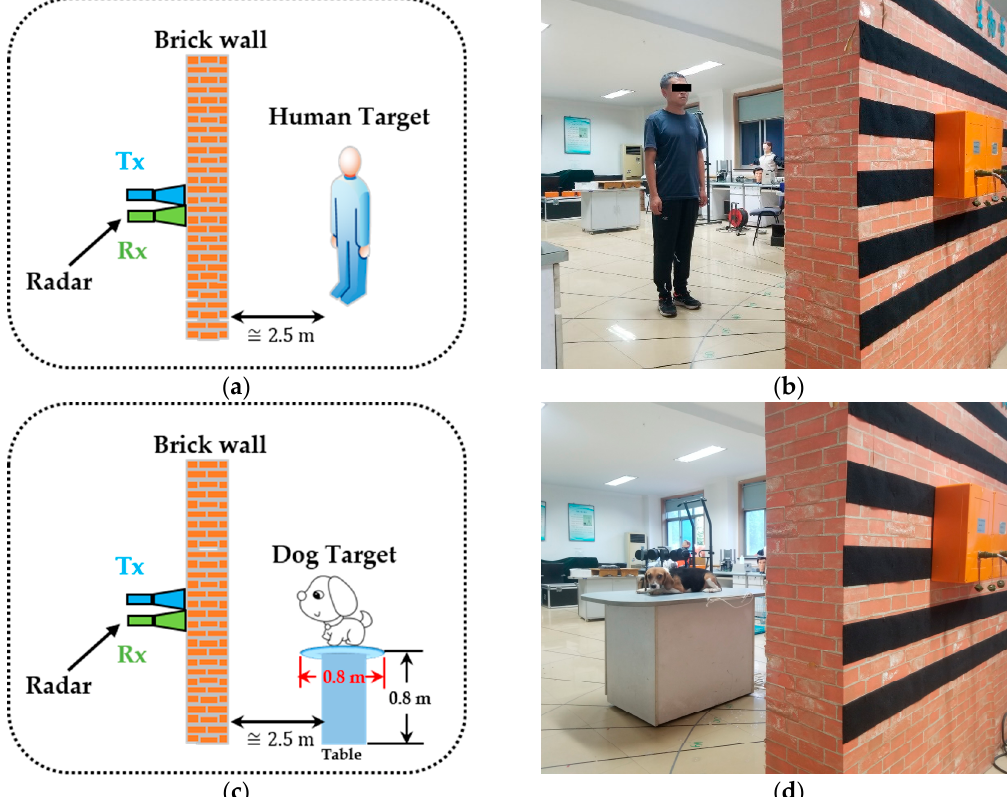
Figure 10. Photographs and geometries of experiments: ( a ) Sketch map of human target measuring; ( b ) actual measuring photographs of human target; ( c ) sketch map of dog target measuring; ( d ) actual measuring photographs of dog target.